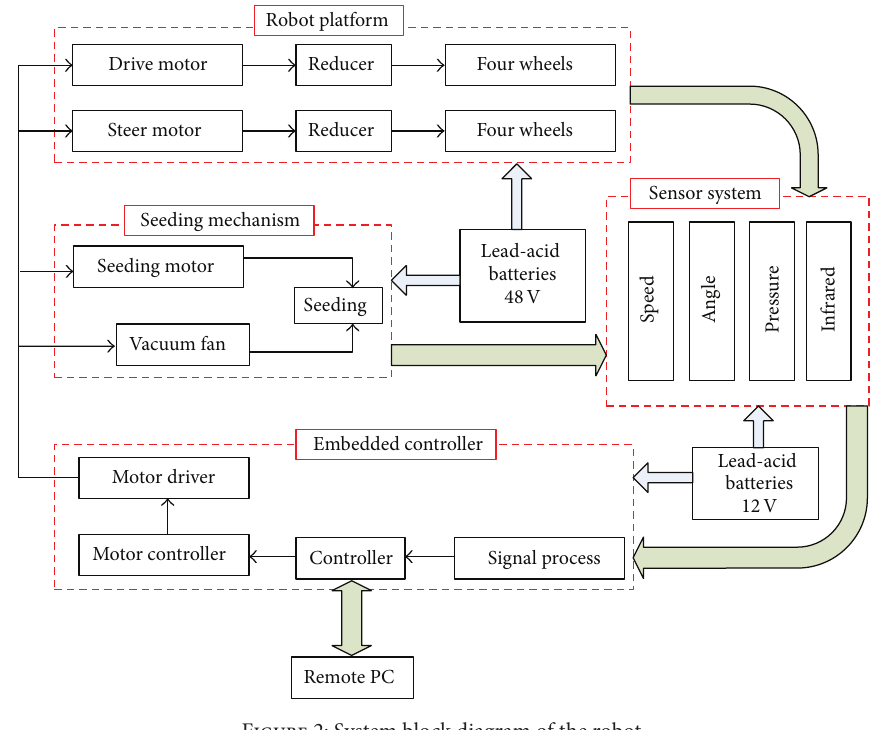
Figure 2: System block diagram of the